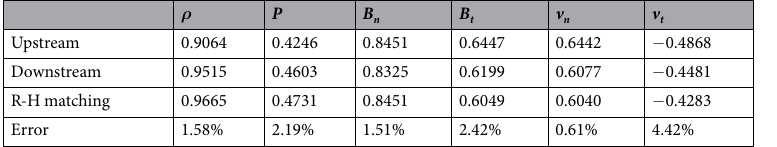
Table 1. The variables from the Rankine-Hugoniot Relations for the shock at z = 1 for t = 51 in Fig.